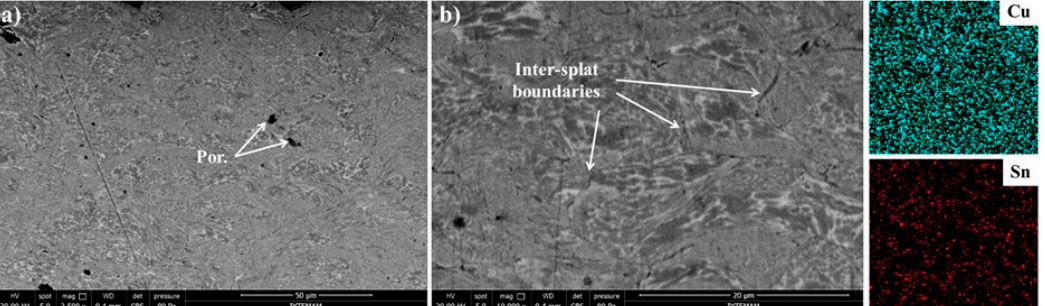
Figure 7. SEM cross-sectional microstructures at higher magnifications show porosity and flattened particle splat boundaries, as well as EDS maps with Cu and Sn element distribution.